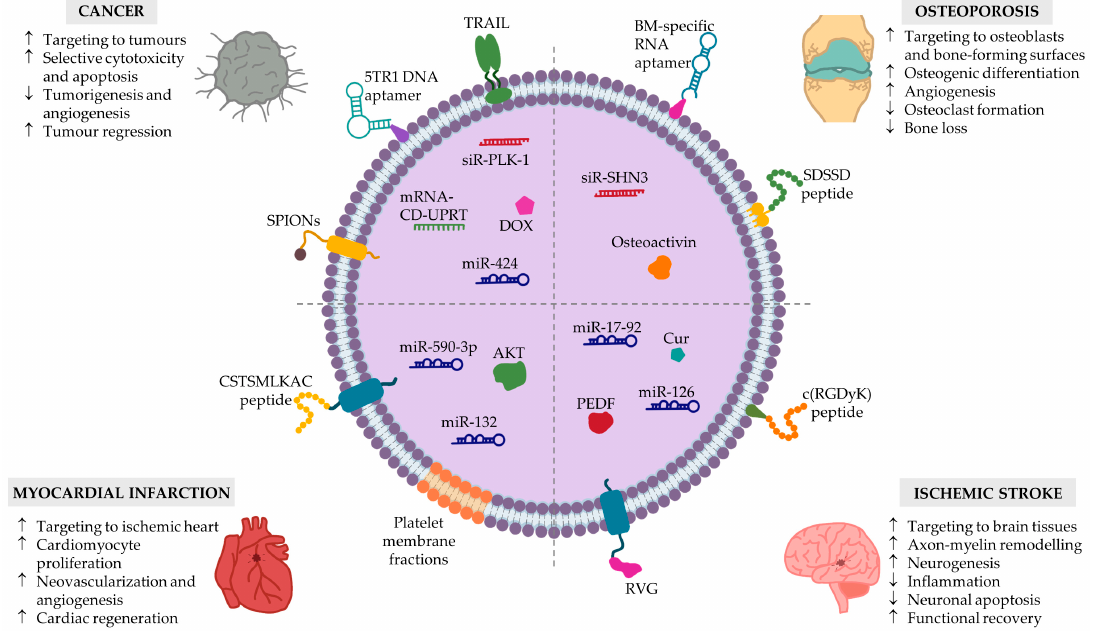
Figure 3. Representative applications of bioengineered MSC-EVs with improved therapeutic payload and target specificity in the treatment of cancer [93,98,113,115,127,140,141], osteoporosis